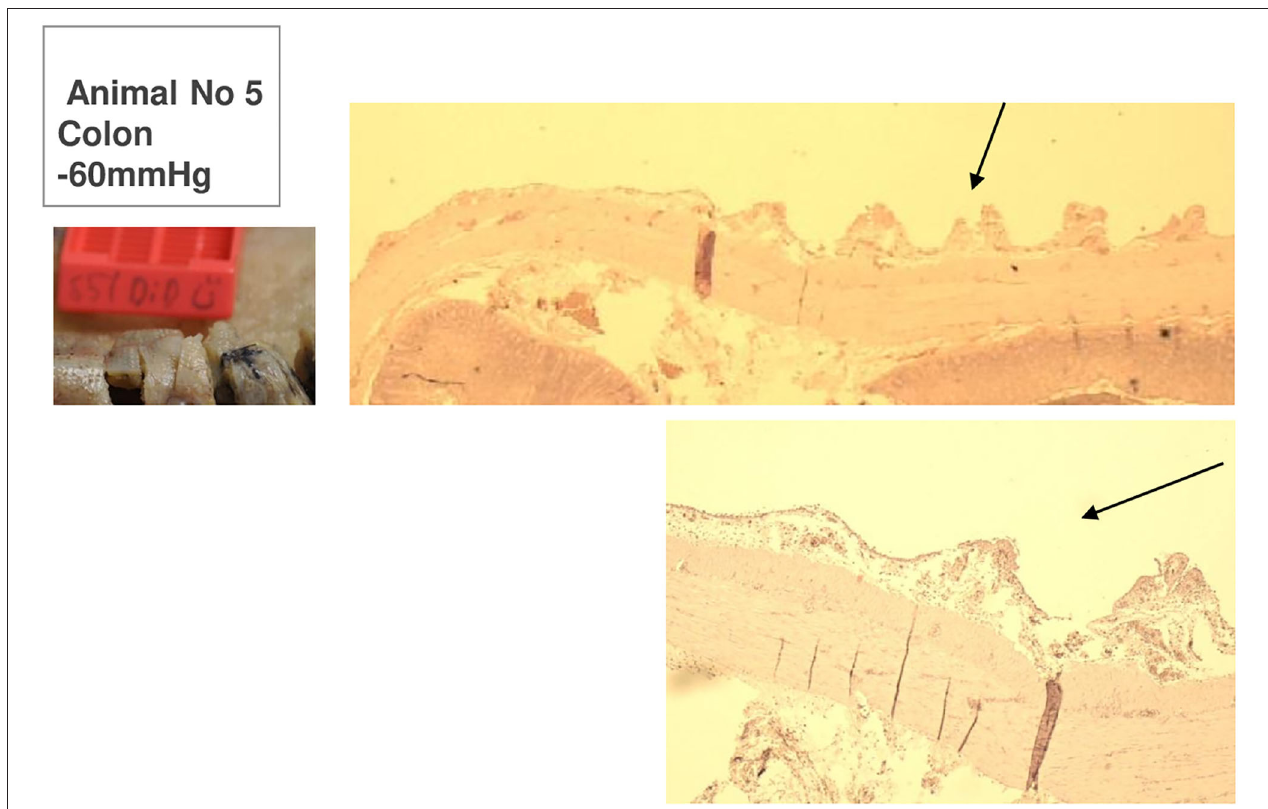
FIGURE 9 | Animal 5, − 60 mmHg. Colon histology. Transition patch and non-patch area. In the patch area (arrows) extensions of the serosa and subserosa. Lamina muscularis propria would not be pulled